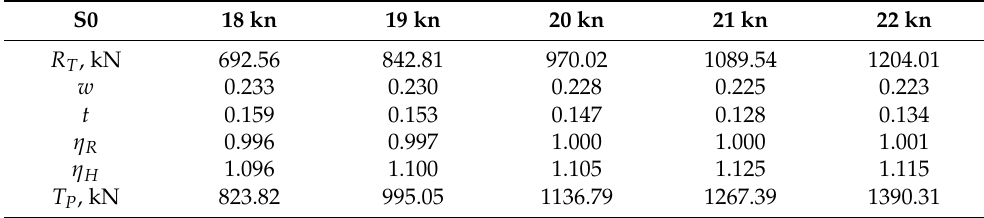
Table 3. The total resistance of a ship and propulsion characteristics in calm water